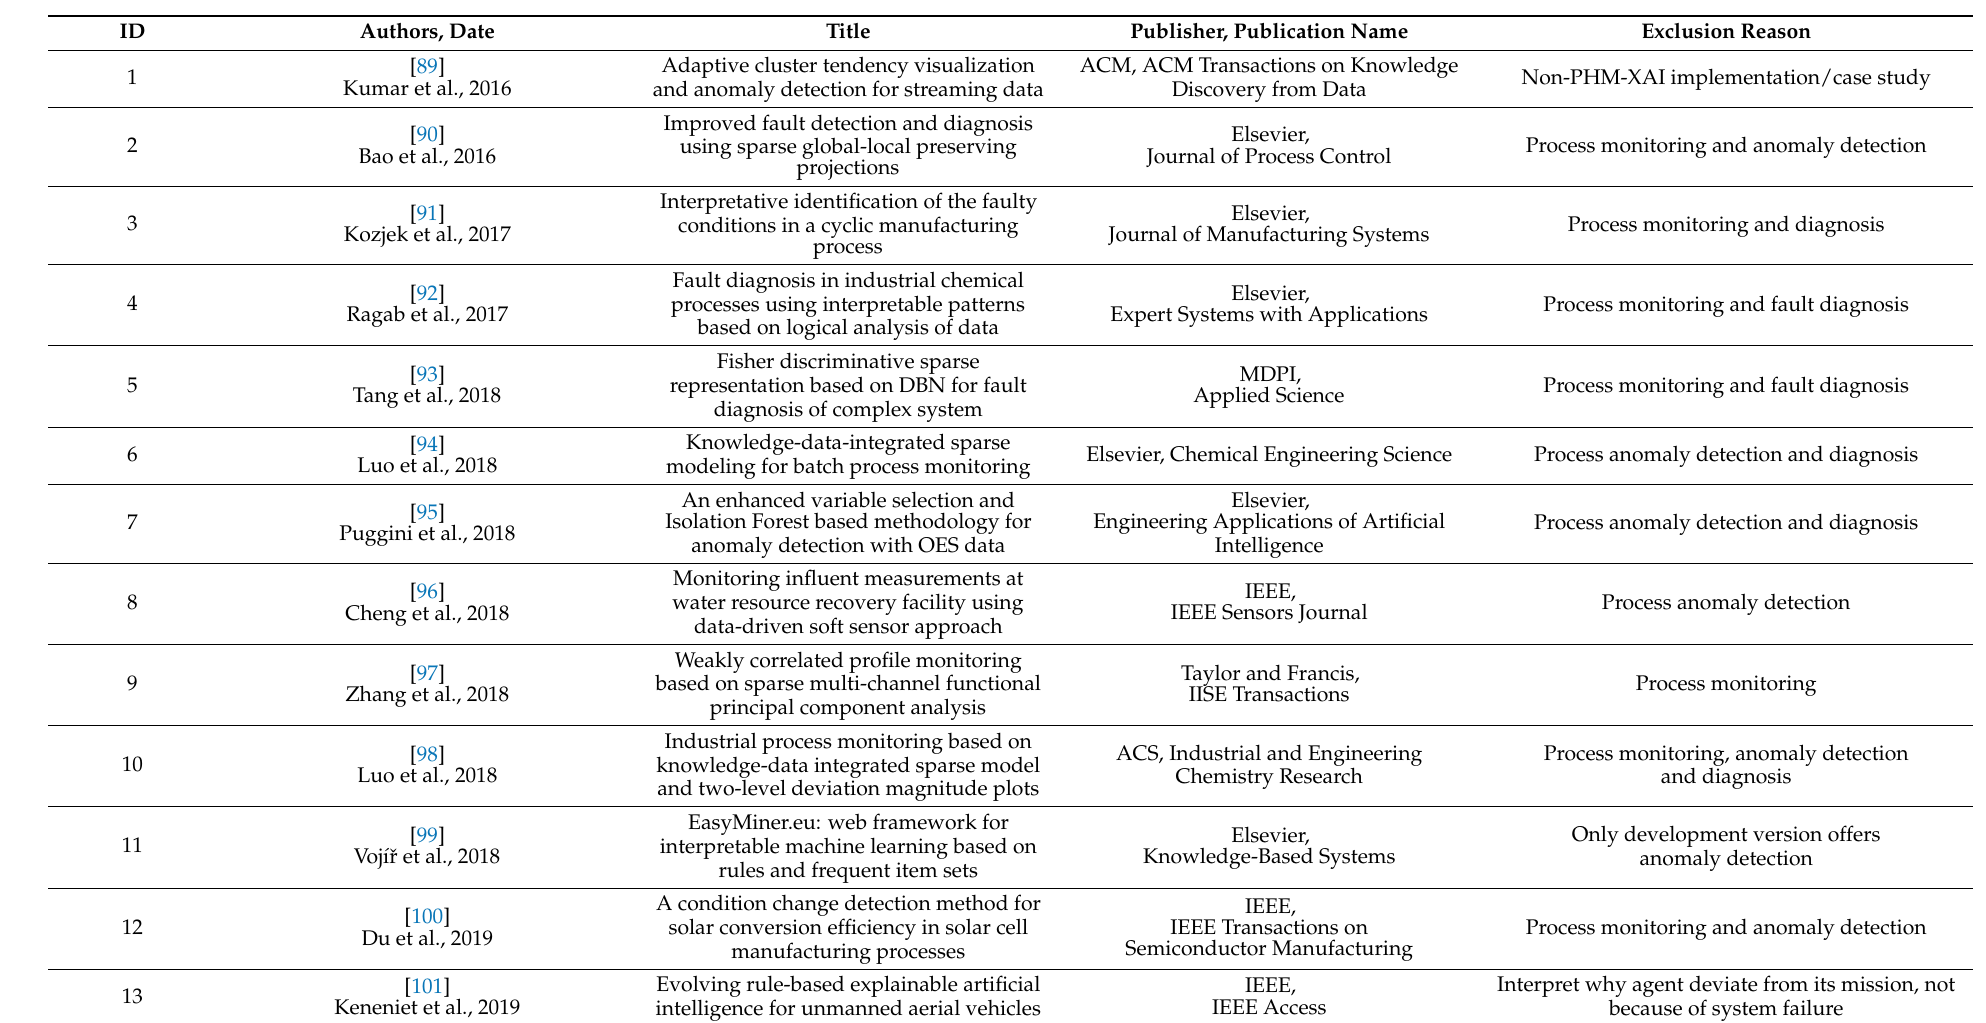
Table A2. Excluded articles according to the publication